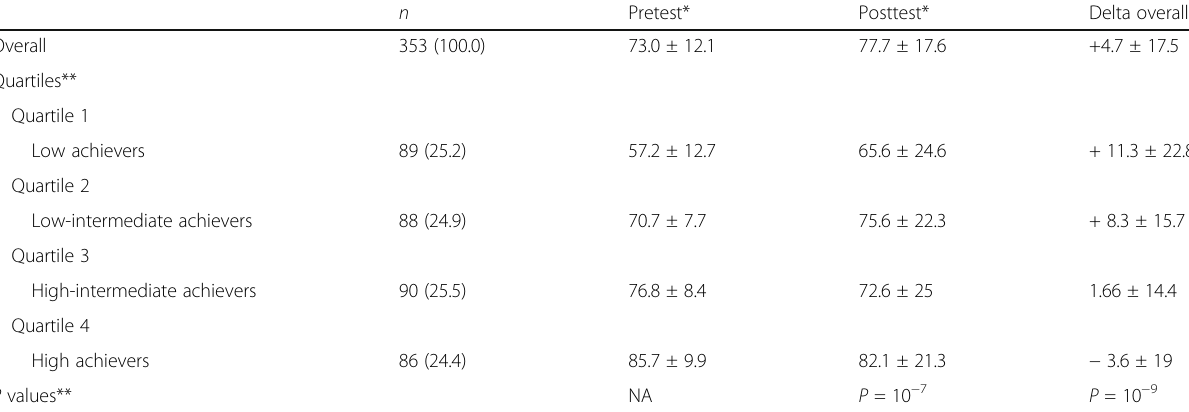
Table 3 Students ’ results and distribution according pretest results quartiles